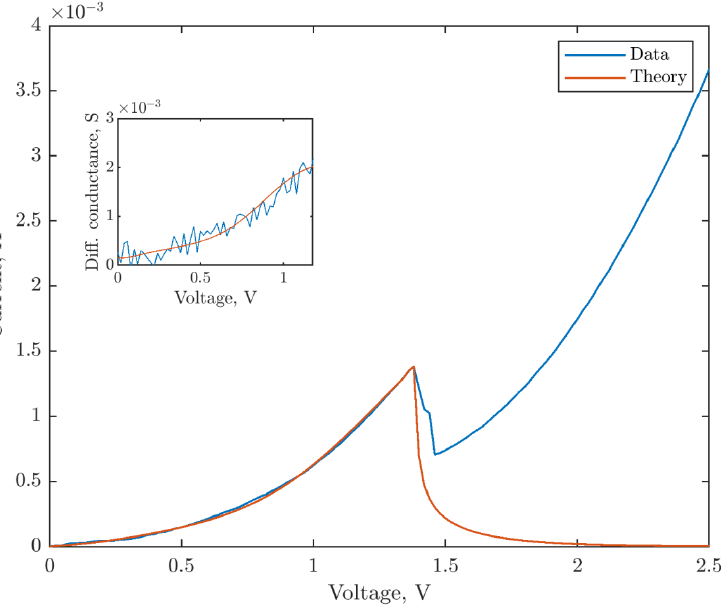
Figure 4. Experimental current – voltage characteristics of RTD No. 2 in comparison with use of the compact model. Table 1. Experimental and simulated RTD parameters.